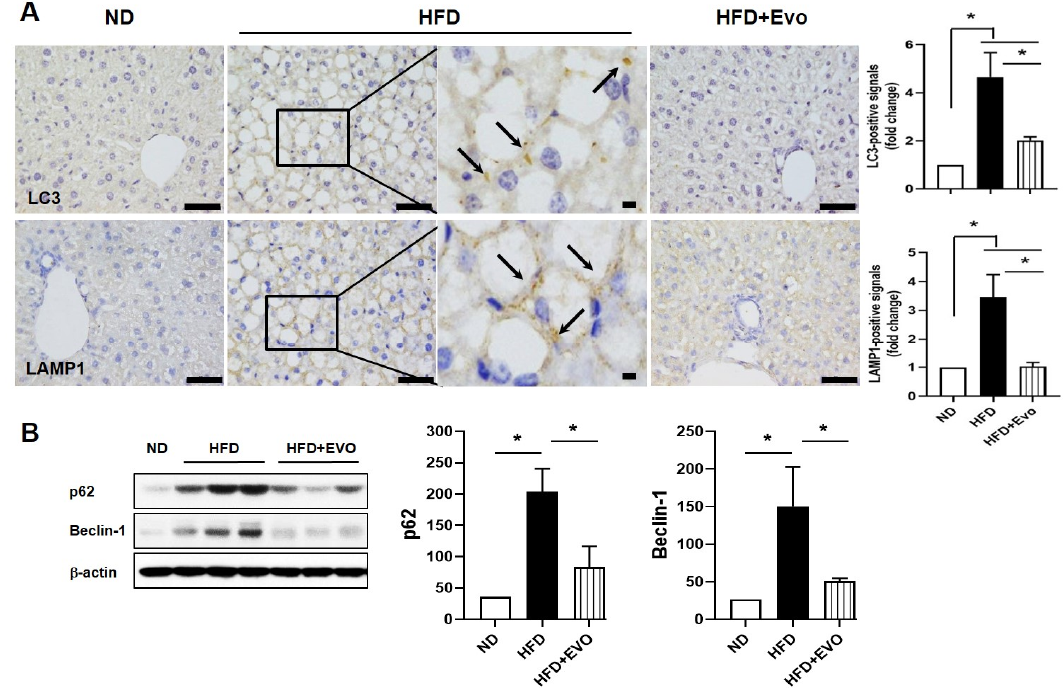
Figure 4. Evogliptin decreased the levels of autophagy-related proteins. ( A ) Representative immunohistochemical liver images for LC3 and LAMP-1 from each group: HFD-induced positive signals (black box) were magnified and indicated as arrows. Scale bar, 50 µ m. ( B ) Protein expressions related to autophagy and the quantitative results: values are mean ± SEM. * p < 0.05, HFD: high-fat diet; ND: normal diet.